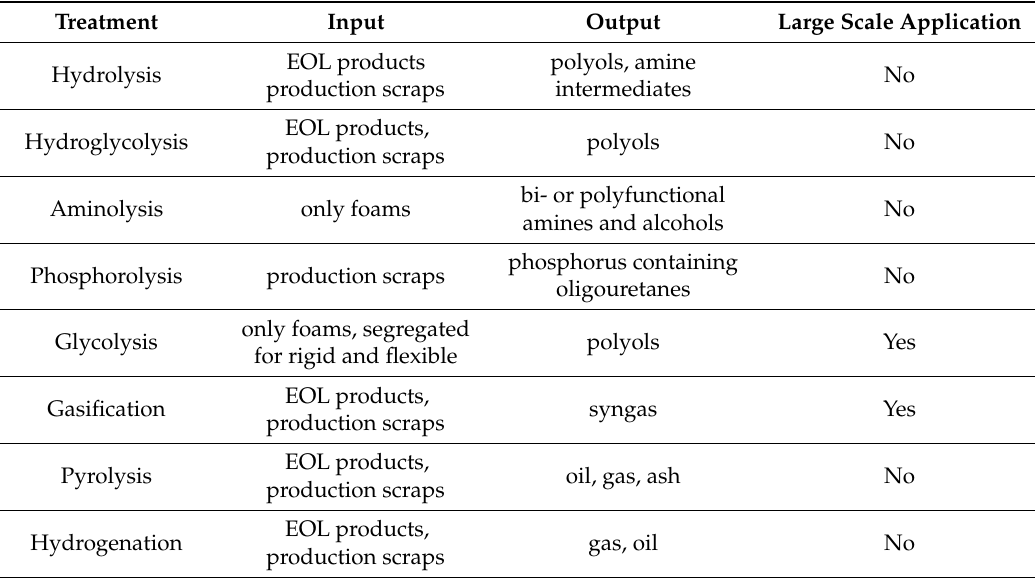
Table 2. Comparison of chemical polyurethane recycling